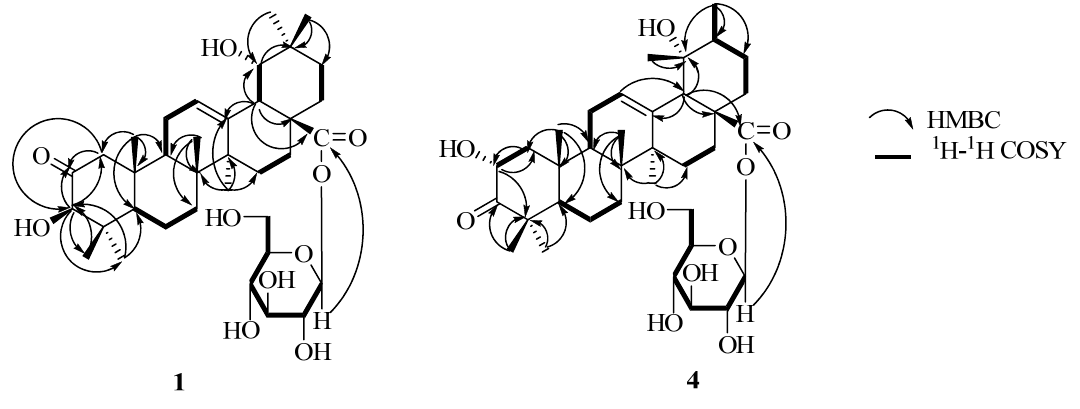
Figure 2. Key HMBC and 1 H- 1 H COSY correlations of 1 and 4 .